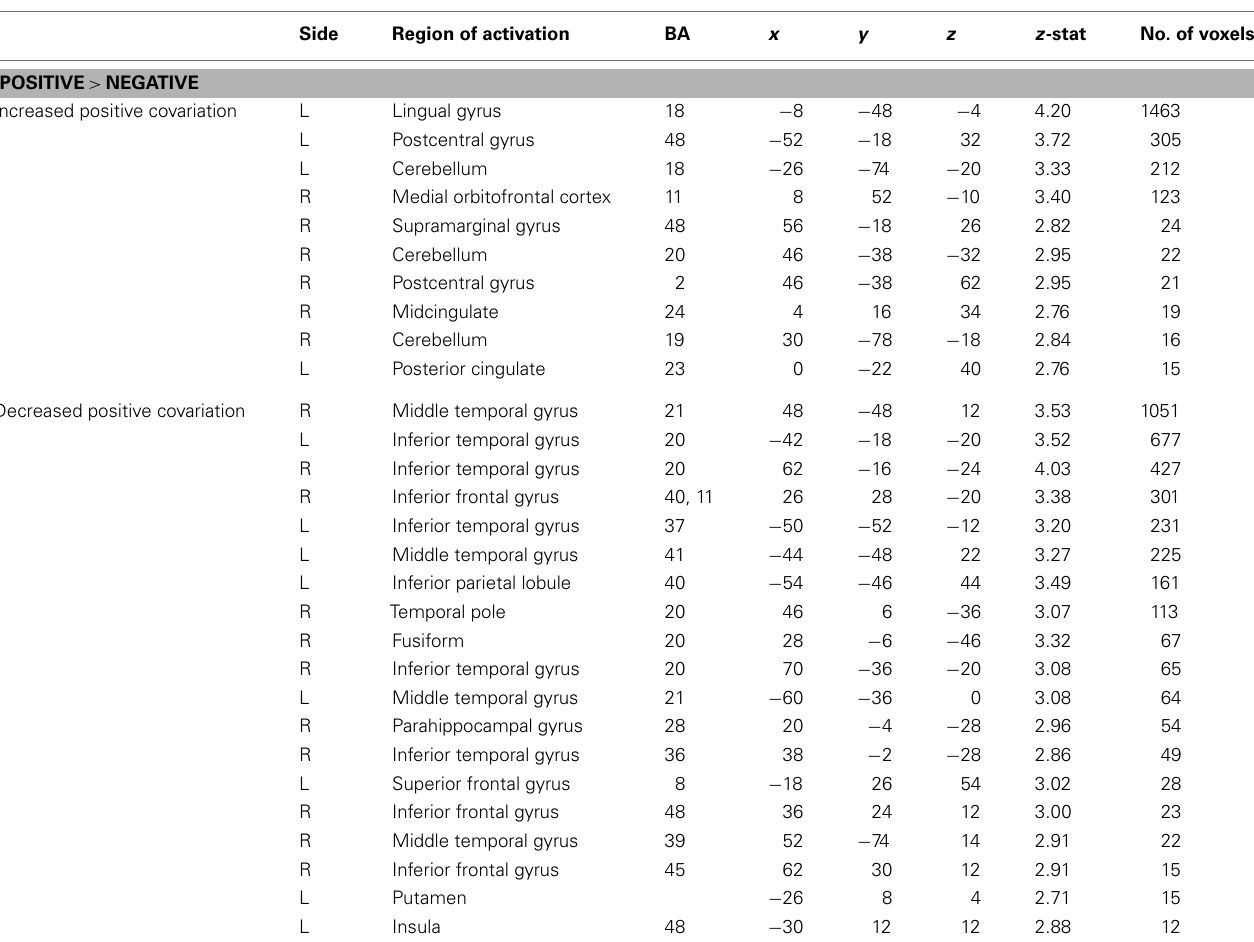
Table 1 | PPI connectivity analyses withVACC seed from data published in Beer and Hughes